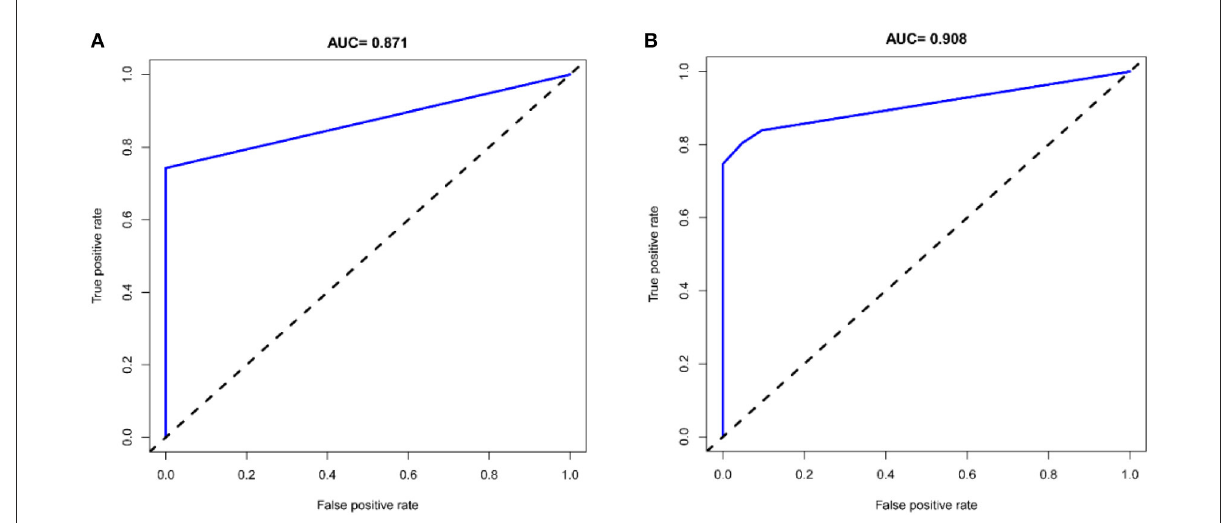
FIGURE10 ROC curves for the model in the validation dataset of GSE75214 (A) and GSE92415 (B)